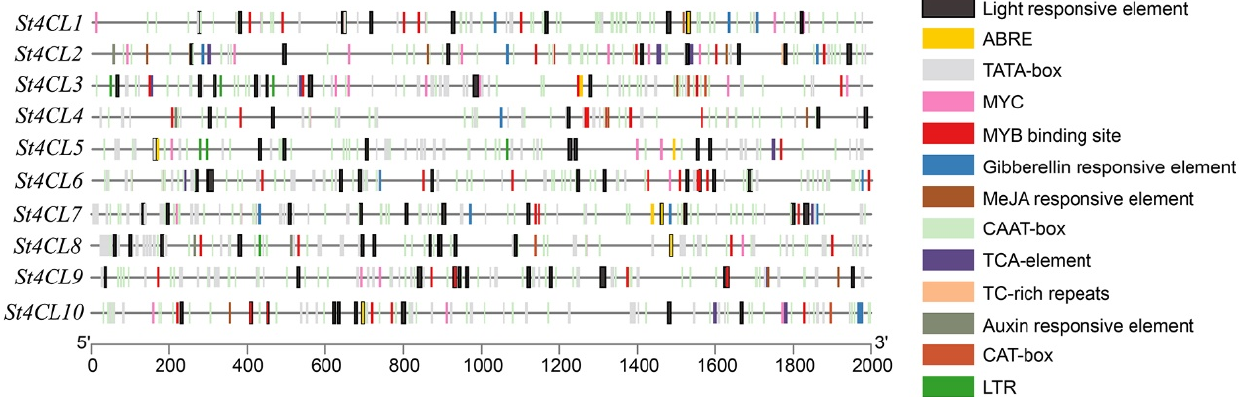
Figure 6. Analysis of cis-acting elements in the St4CL gene promoters. The genomic sequence 2000 bp upstream of the start codon was selected as the promoter for analysis.